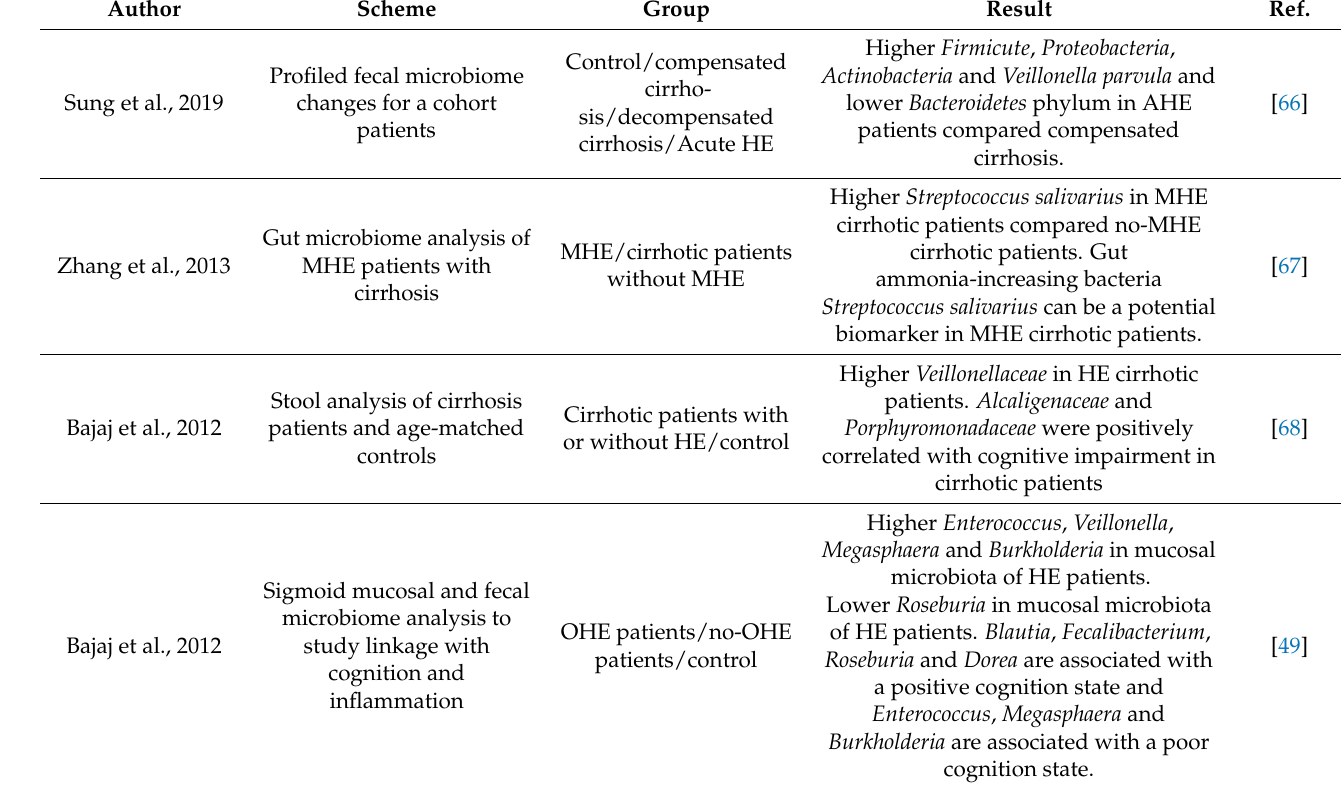
Table 1. Human study of microbiome change in cirrhosis with hepatic